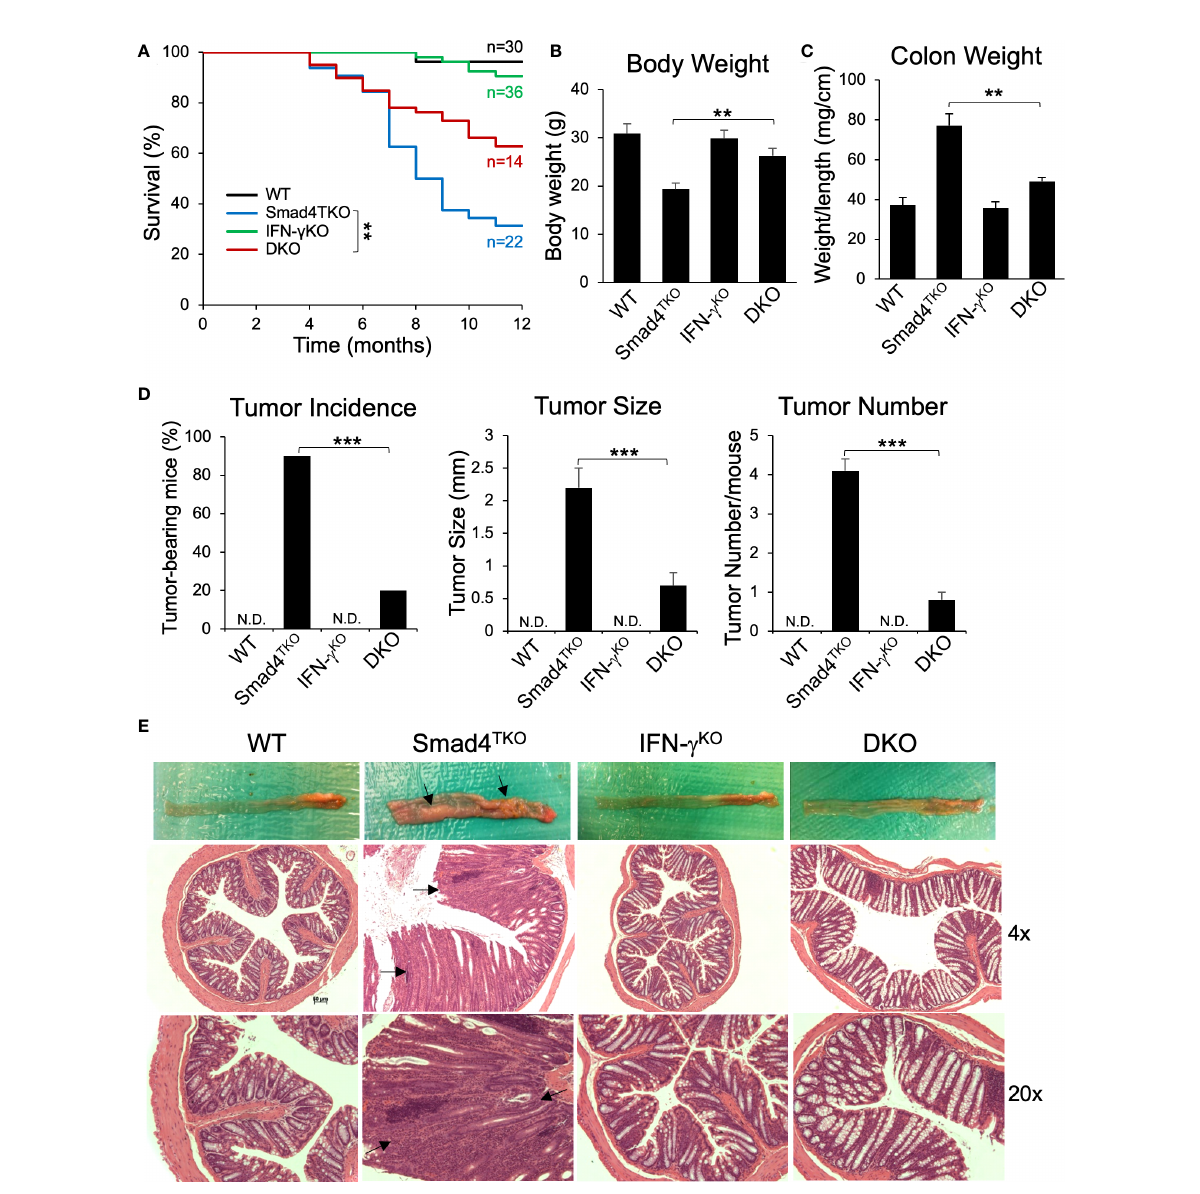
FIGURE 3 Deletion of IFN- g in Smad4 TKO mice ameliorates colitis-associated colon cancer. (A) Survival curves of WT, Smad4 TKO , IFN- g KO and Smad4 TKO / IFN- g KO (DKO) mice. (B) Body weight of each genotype at 8 months of age (n=11). (C) Colon weight per length (mg/cm) (n=9). (D) Percentage of tumor-bearing mice (n=10), tumor size (n=7) and tumor numbers per mouse at 8 months of age were determined using a digital eyepiece and an imageJ (n=7). (E) Gross necropsy and hematoxylin and eosin (H&E) staining of the colon of each genotype at 8 months of age. Paraf fi n- embedded sections were stained with H&E. Error bars indicate S.E.; ** p < 0.01, ***p < 0.001 compared with Smad4 TKO